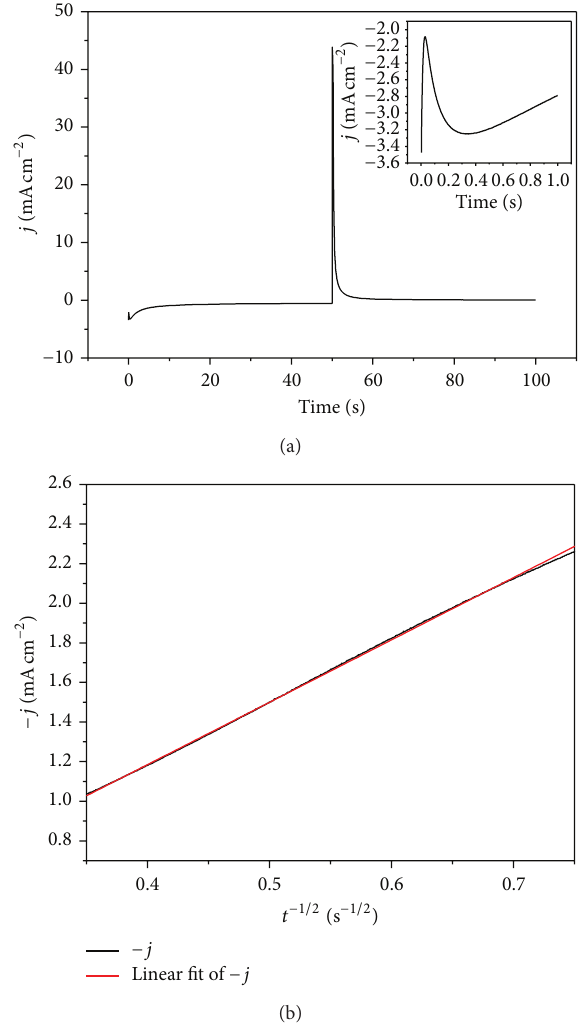
Figure 6: (a) Potentiostatic current transient of Zn deposition on GaN; the inset shows an enlargement of the transient curve for the first seconds; (b) Cottrell plot for the determination of the diffusion coefficient of Zn 2+